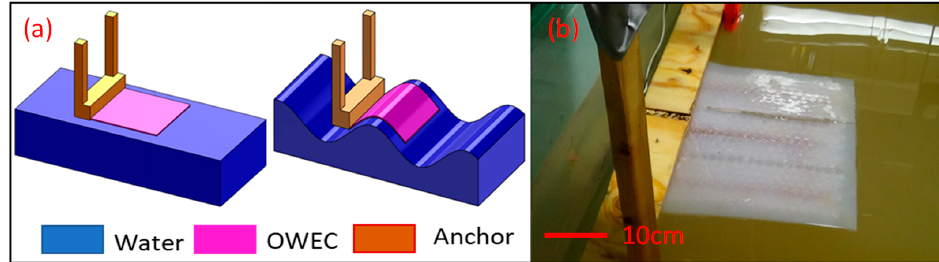
Figure 10. The horizontal one-sided anchoring (schematics not to scale). ( a ) Schematic of the one-sided anchored OWEC. ( b ) Photographic image of the one-sided anchored OWEC.